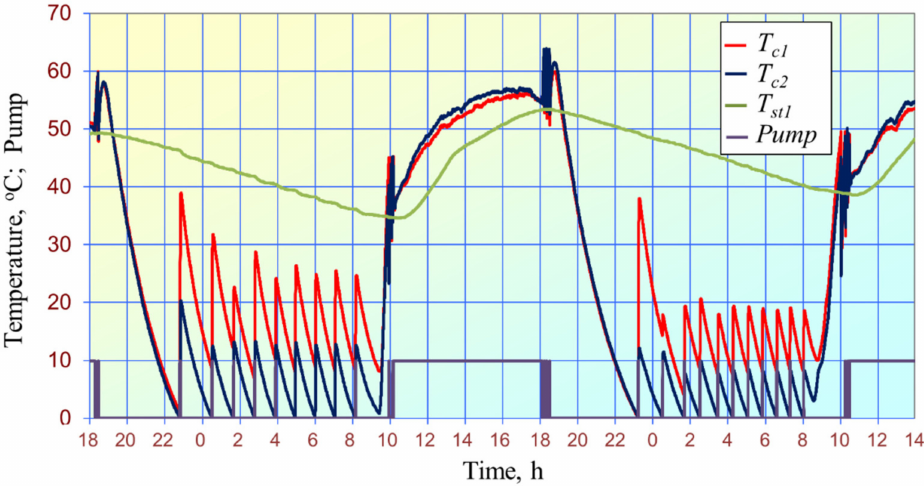
Figure 15. Night and day temperatures of collectors with circulating pump control for the average temperature of collector 2, measurements taken between 13 and 15 March